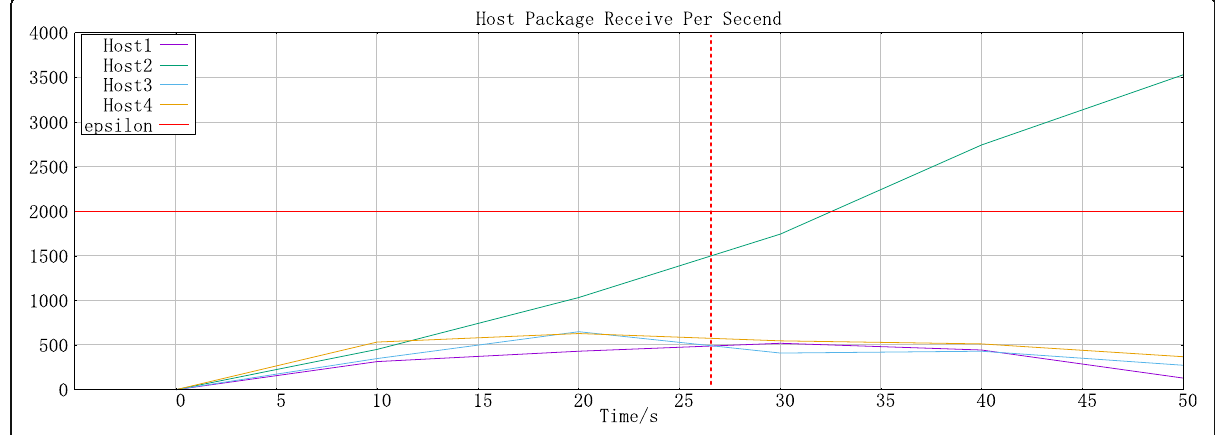
Fig. 8 Cloud packet receiving frequency fragment